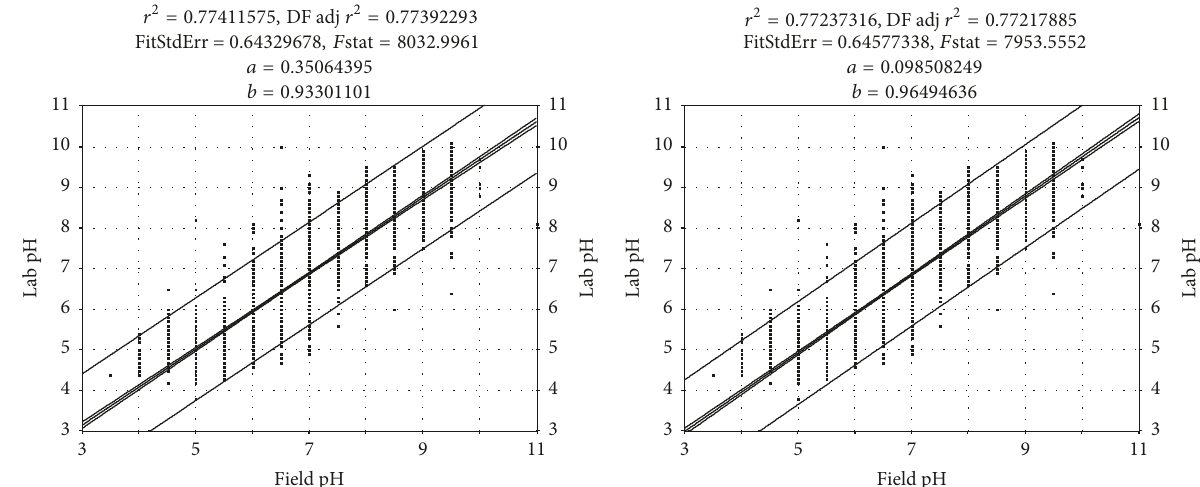
(a) Linear model (original data) for field pH F versus pH W with least- squares minimisation and 95 % CI (narrow band) and 95 % PI (broad